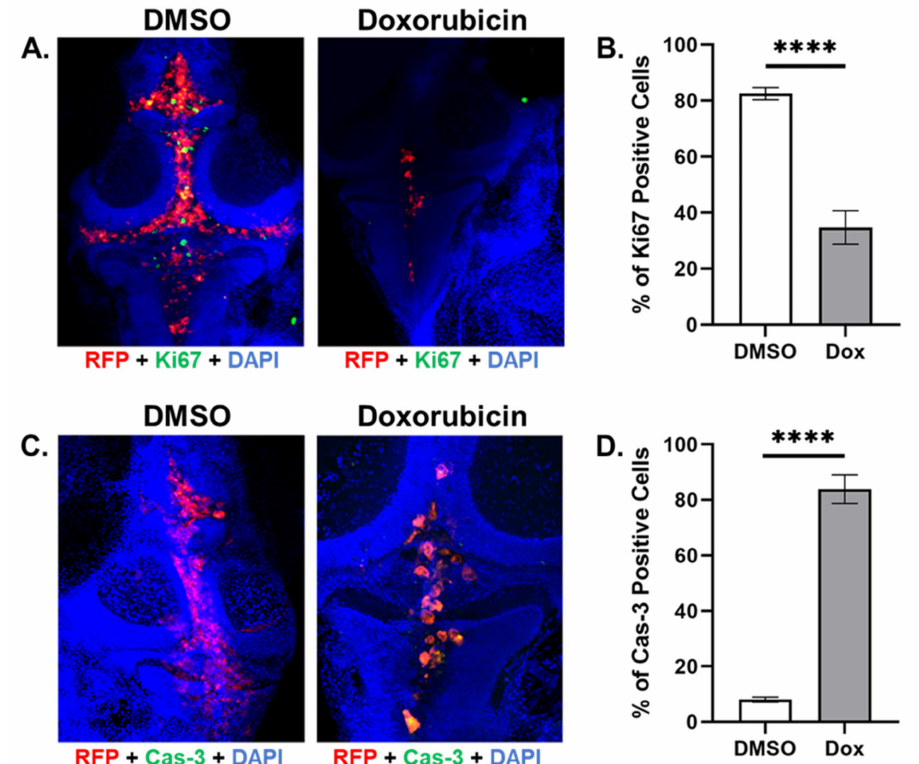
Figure 5. Doxorubicin treatment decreased cell proliferation and increased cell death compared to DMSO vehicle in zebrafish MDA-MB-231 TNBC xenografts. ( A ). Z-stack analysis combining red (MDA-MB-231-Luc/RFP cells), green (Ki67-stained cells), and blue (DAPI-nuclear-stained cells) filter images show that xenograft samples treated with DMSO vehicle exhibited more Ki67 staining than samples treated with doxorubicin at 8 dpi. ( B ). Doxorubicin treatment reduced the percentage of Ki67-positive cells compared to DMSO-vehicle-treated cells at 8 dpi. ( C ). Z-stack analysis combining red (MDA-MB-231-Luc/RFP cells), green (cleaved-caspase-3-stained cells), and blue (DAPI-nuclear- stained cells) filter images show that xenograft samples treated with DMSO vehicle exhibited more cleaved caspase-3 staining than samples treated with doxorubicin at 8 dpi. ( D ). Doxorubicin treatment increased the percentage of cleaved-caspase-3-positive cells compared to DMSO-vehicle-treated cells at 8 dpi. Key: RFP = red fluorescent protein; DAPI = 4 (cid:48) ,6-diamidino-2-phenylindole; Cas-3 = caspase-3; Dox = doxorubicin. N = 10; “****” = p < 0.0001; Error bars =